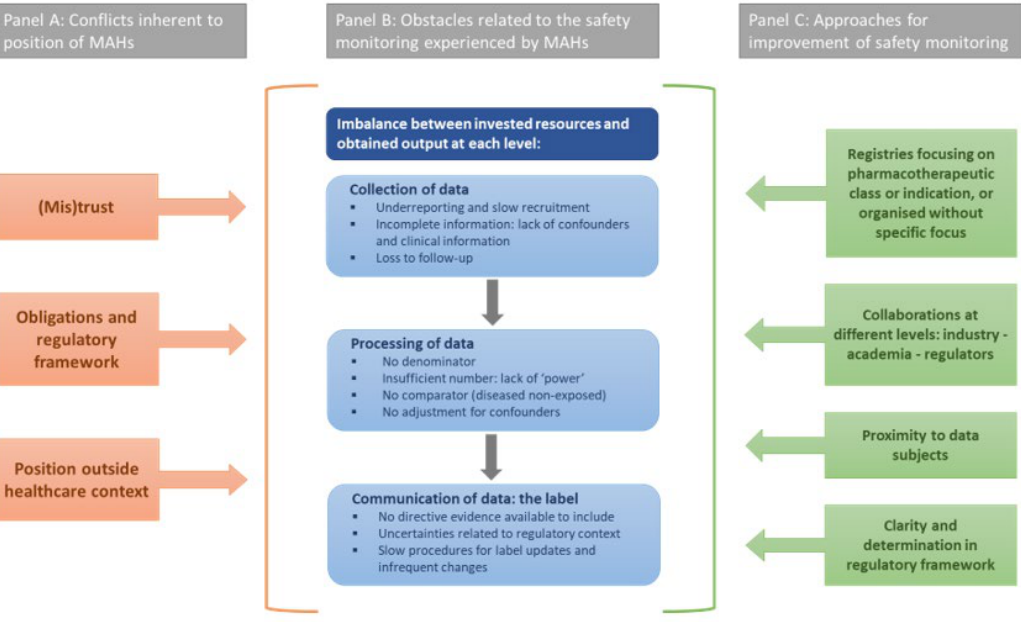
Figure 2. Overview of the obstacles related to the safety monitoring experienced by MAHs ( panel B ), including underlying conflicts ( panel A ) and approaches for future improvement ( panel C ).